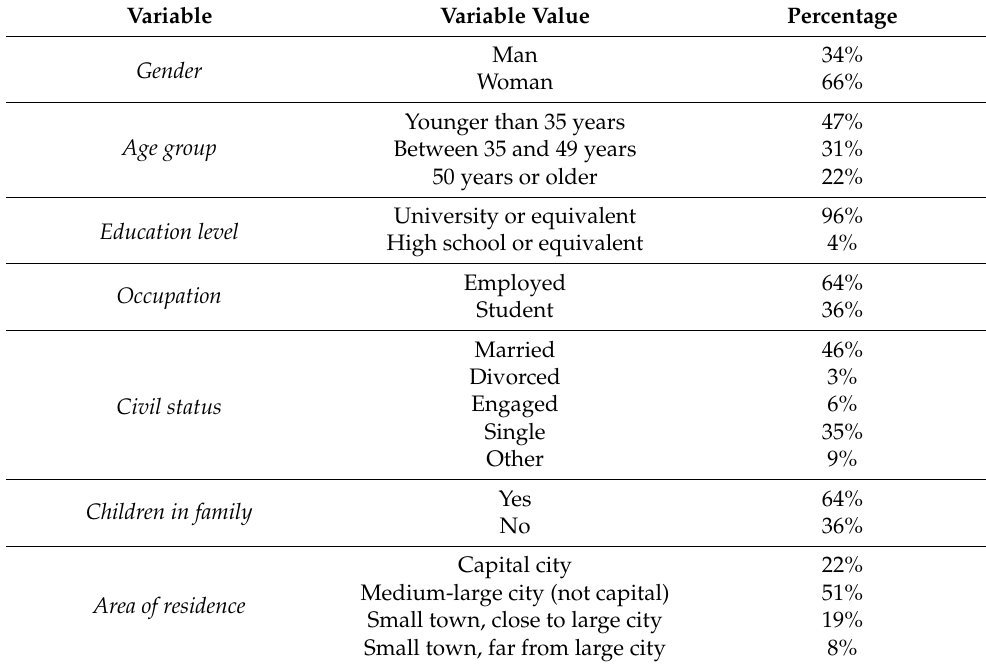
Table 1. Sample characteristics ( n =